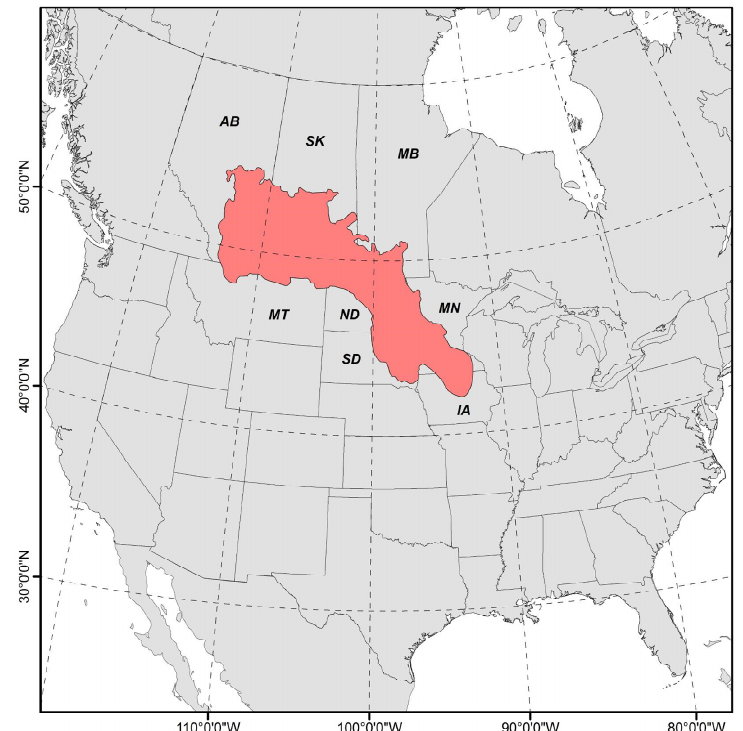
Figure A1. Study area map of the Prairie Pothole Region in central North America (Modified from Liu and Schwartz [2012]). Notes: AB, Alberta; SK, Saskatchewan; MB, Manitoba; MN, Montana; ND, North Dakota; SD, South Dakota; IA,